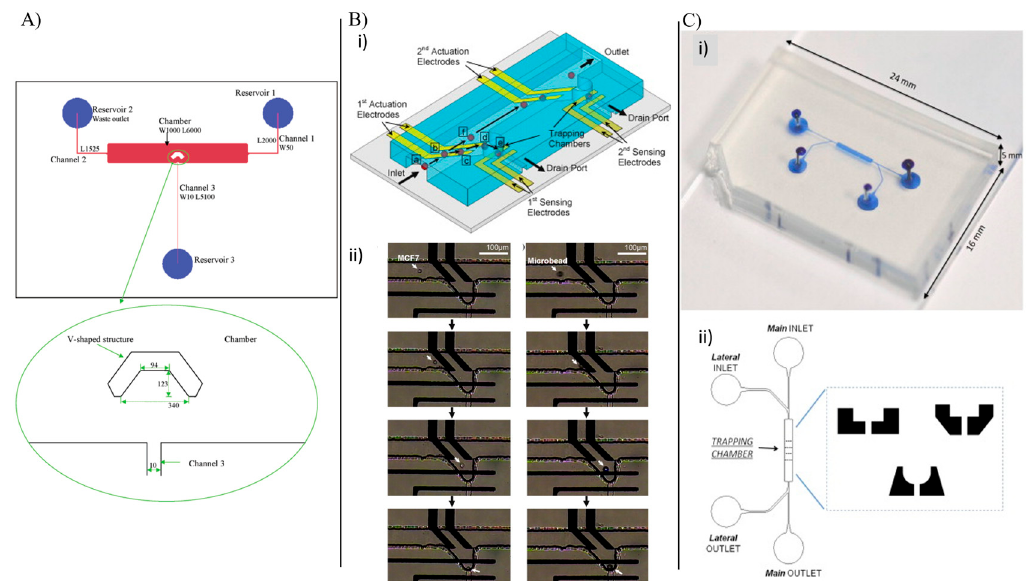
Figure 1. Microtrapping of cells ( A ) Schematic showing design of the microfluidic device and V- shaped trapping structure with dimensions (reproduced with permission from [44]). ( B ) (i) Design of microfluidic chip with trapping chambers and (ii) sequential trapping of MCF cell (left) and microbead (right) in trapping chamber (reproduced with permission from [46]). ( C ) (i) Image of microfluidic platform with inlets, outlets, and trapping chambers with (ii) three different geometries of micro-traps for trapping of cells (reproduced with permission from [47]).